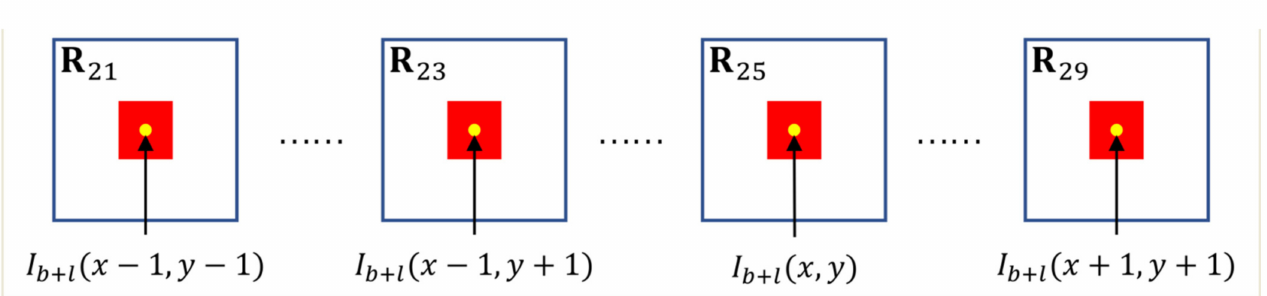
Figure 3. Local spatial–temporal matching and reverse matching.